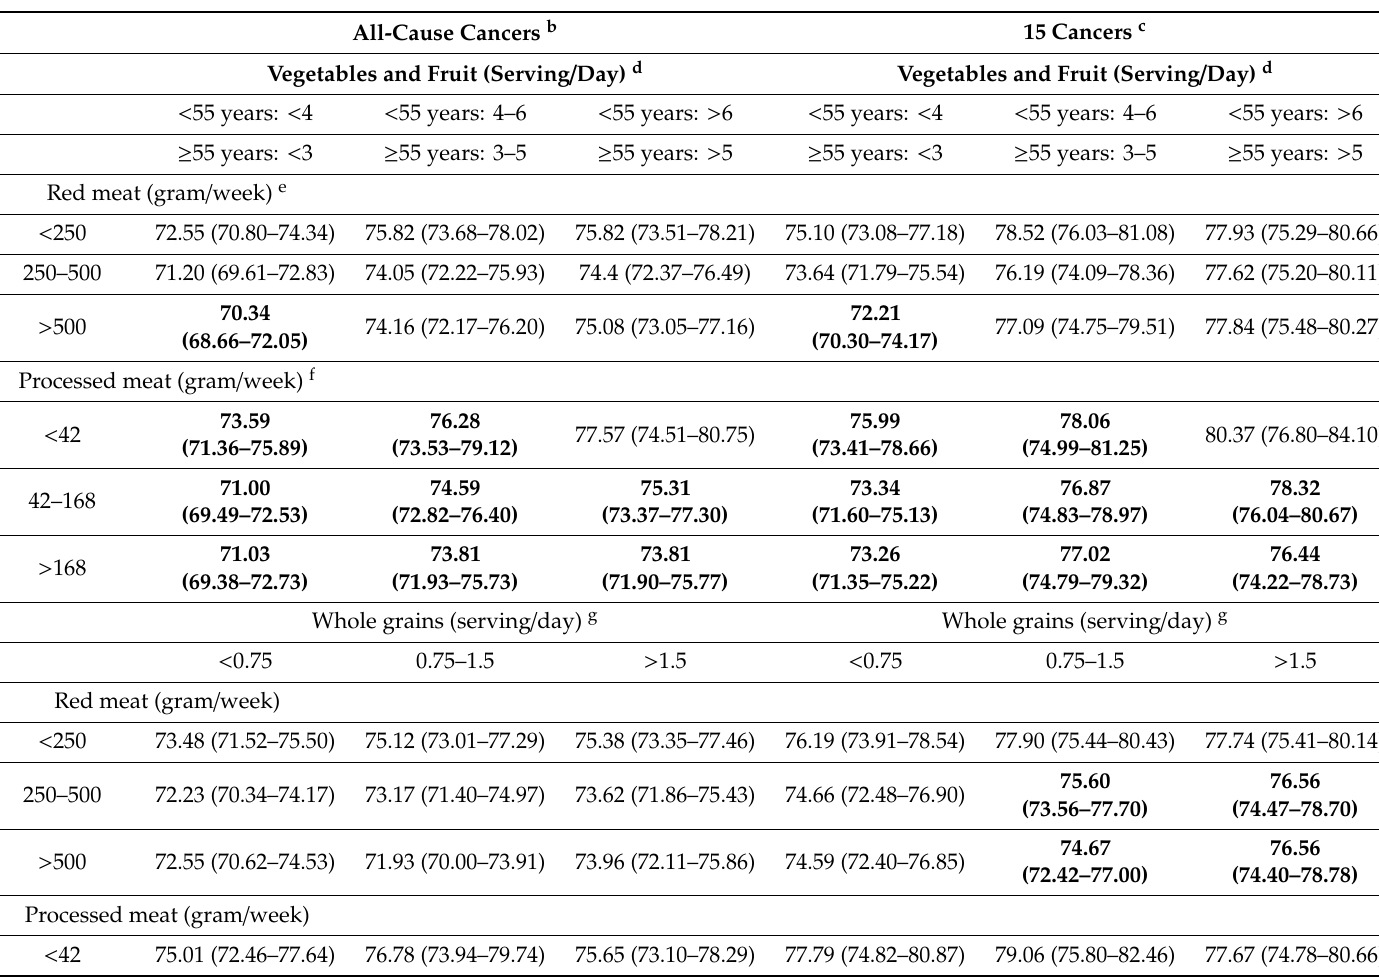
Table 4. Estimated median ages a and confidence intervals for all-cause and 15 cancer incidence for di ff erent combinations of intake levels of red and processed meat with vegetables and fruit, whole grains, and fiber among men, Alberta’s Tomorrow Project ( n =